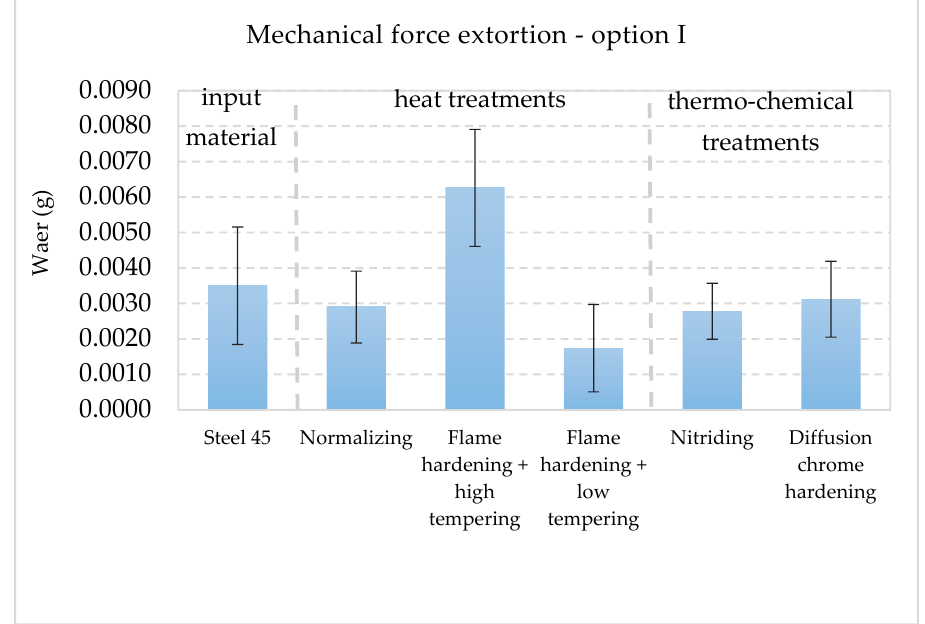
Figure 13. Wear I M values in the conditions of mechanical extortion (no action from abrasive and corrosive agents) [40].